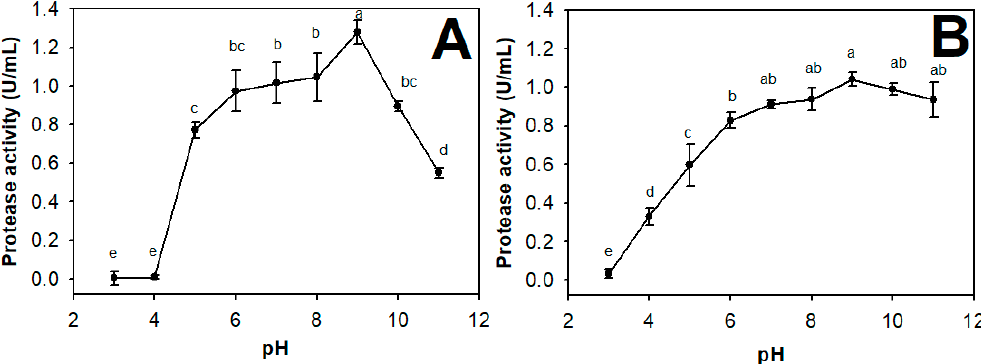
Figure 6. Effect of pH on activity ( A ) and stability ( B ) of Paenibacillus sp. TKU047 protease. All points on the graph indicate the mean of each experiment (with n = 3) and standard deviation (error bar). Different letters (a, b, c, d, and e) indicate significant difference based on Tukey’s test with p < 0.05.